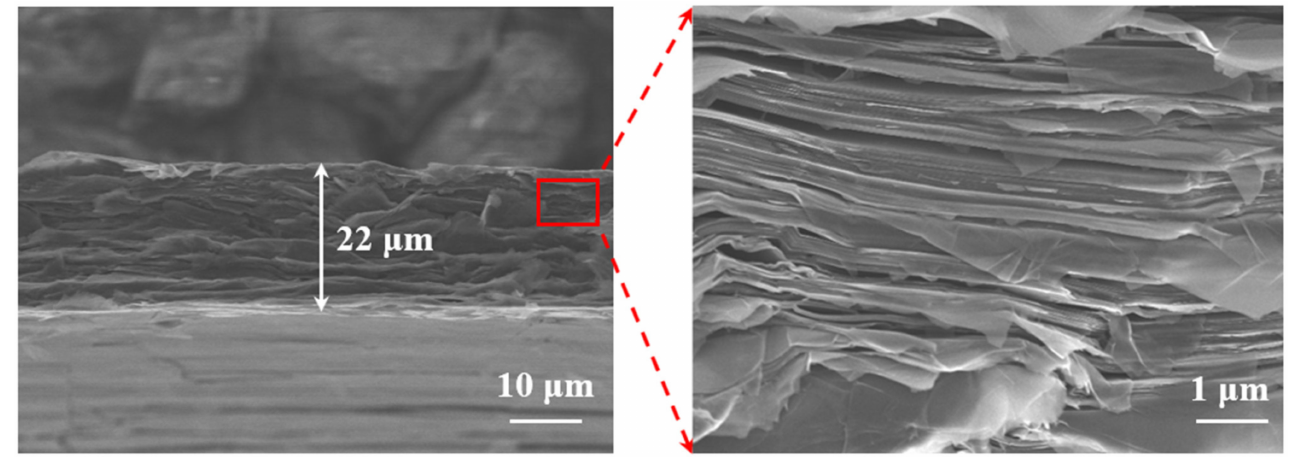
Figure 2. The cross-sectional and the highly magnified SEM images of the HCGAF. Second, XRD patterns were collected using X-ray D/MAX-RB instruments with Cu Ka radiation, and Raman spectroscopy was performed using a Renishaw Raman Spectrometer. The sharp diffraction peak of the (002) plane in the X-ray diffraction (XRD) pattern was located at 2 θ = 26.5 ◦ (Figure 3), indicating an interlayer spacing of 0.336 nm. The unobvious D band (1329 cm − 1 ) and strong 2D band (2684 cm − 1 ) in the Raman spectroscopy (inset of Figure 3) indicate a highly graphitized structure [37,38]. Additionally, due to the π –